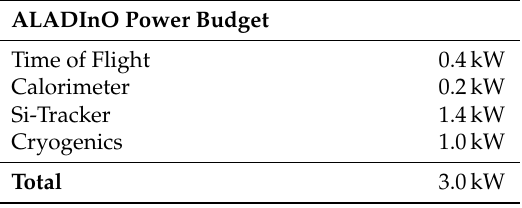
Table 3. Summary of expected power budgets for the main services and detectors of the baseline ALADInO instrument. The estimations for the detectors include FEE and DAQ power consumption.